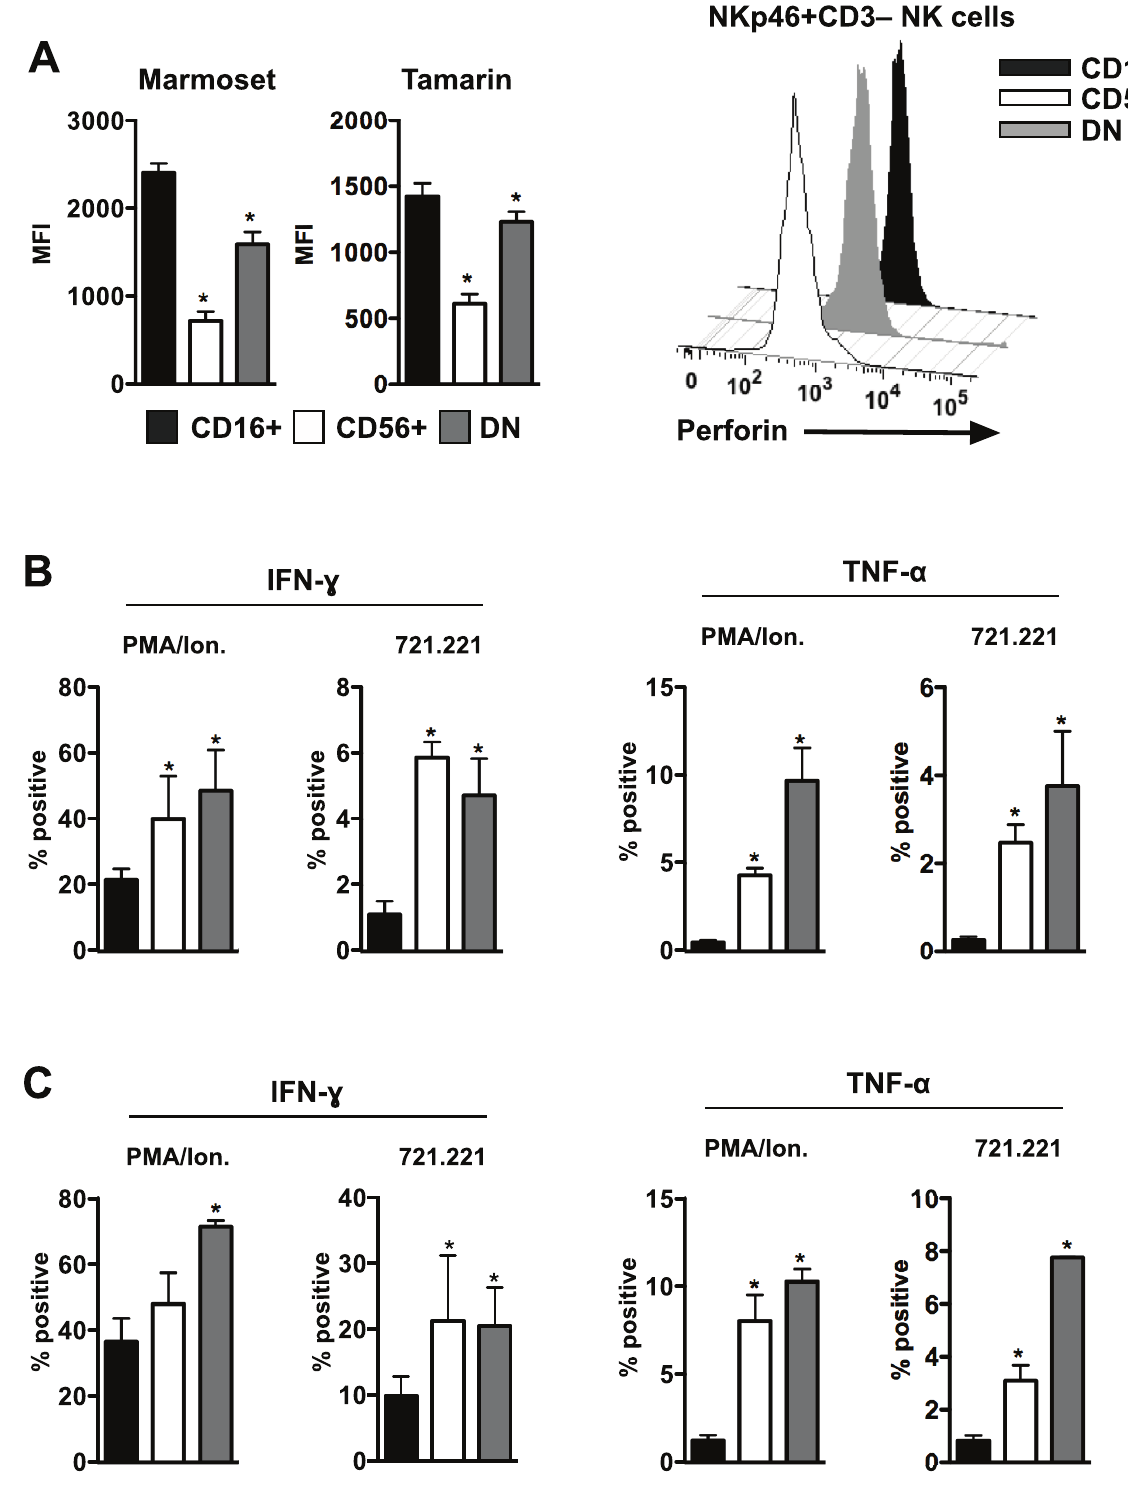
Figure 3. Functional profiles of marmoset and tamarin NK cells. ( A ) MFIs and example histograms of intracellular perforin expression in different NK cell subpopulations ex vivo . Percentages of peripheral blood NK cells from common marmosets ( B ) or cotton-top tamarins ( C ) positive for intracellular IFN- c and TNF- a following PMA/ionomycin or 721.221 stimulation. Bars represent means 6 SEM of 6 animals per group. Wilcoxon matched pairs tests were used for CD16 + NK cells versus CD56 + or DN NK cells; *, P , 0.05. Only statistically significant differences are indicated.